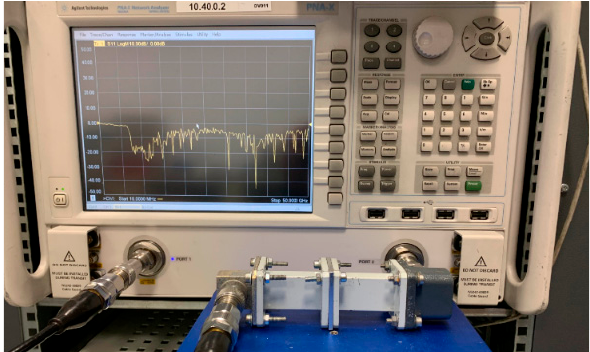
Figure 2. Experimental setup of the waveguide characterization of the printed samples.